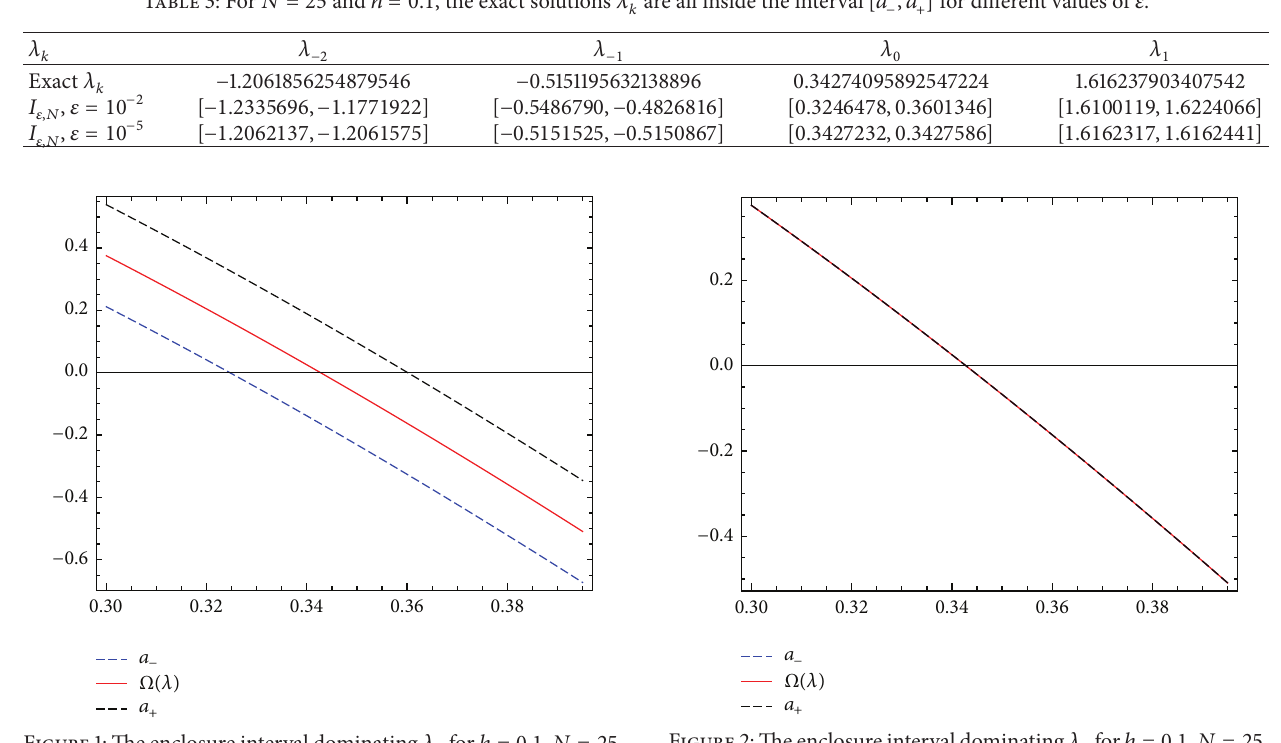
Figure 1: The enclosure interval dominating 𝜆 0 for ℎ = 0.1 , 𝑁 = 25 , and 𝜀 = 10 −2 .